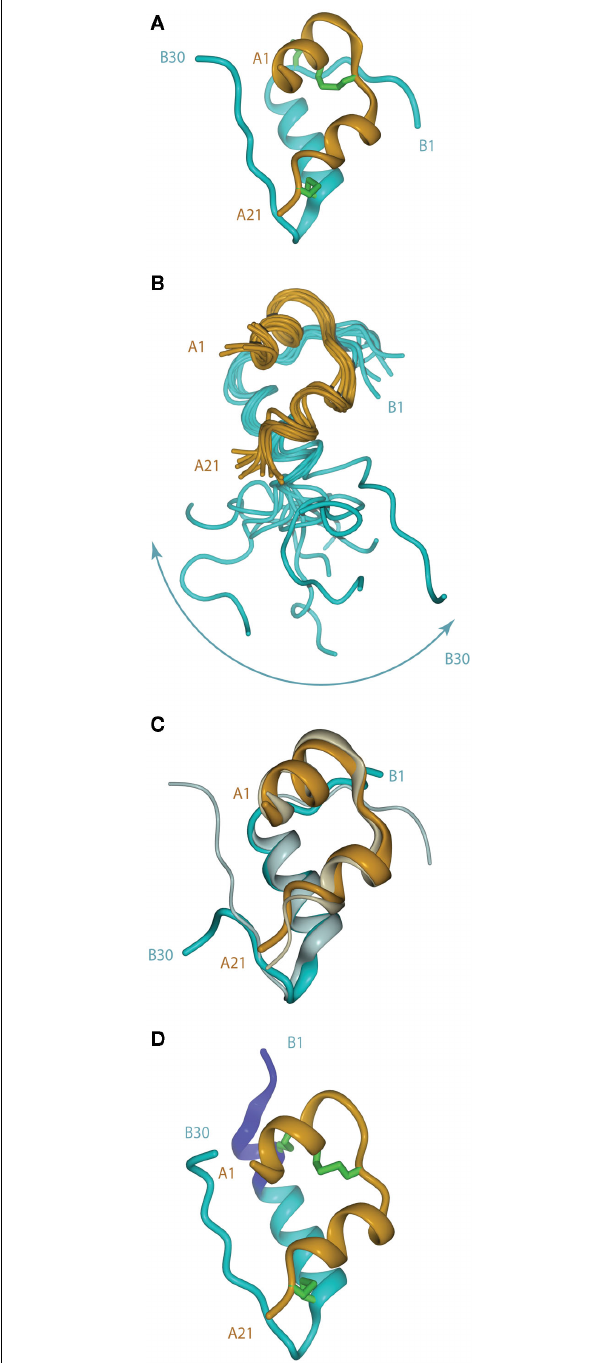
FIGURE 2 | (A) Tertiary structure of the porcine insulin monomer in its 2Zn rhombohedral form (PDB entry 4INS). (B) Structure of the human insulin mutant GlyB24 (PDB entry 1HIT), showing the flexibility of the B-chain C-terminus. (C) Structure of a high affinity N-MeAlaB26 human insulin mutant (PDB entry 2WRX, solid colors) overlaid on that of wild-type hormone (gray). (D) Structure of the so-called R state form of porcine insulin (PDB entry 1ZNI), with the N-terminal extension of the B-chain helix shown in blue. For clarity, disulfide bonds are omitted in (B,C)